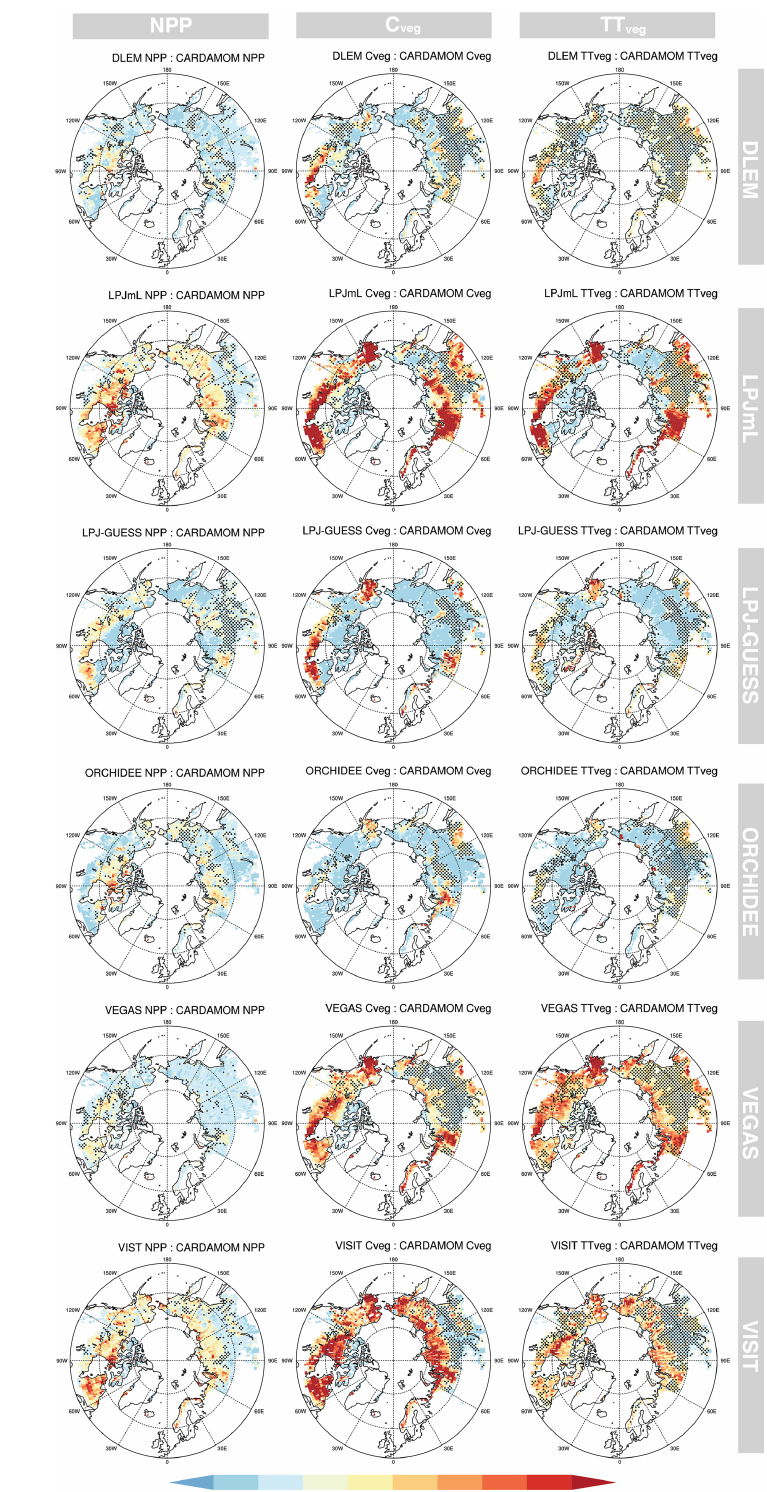
Figure 6. NPP (net primary production), C veg (vegetation C stock), and TT veg (vegetation transit time) ratios between ISI-MIP2a model ensembles (DLEM, LPJmL, LPJ-GUESS, ORCHIDEE, VEGAS, and VISIT) and CARDAMOM. Stippling indicates locations where the ISI-MIP2a model mean is within CARDAMOM’s 5th and 95th percentiles.